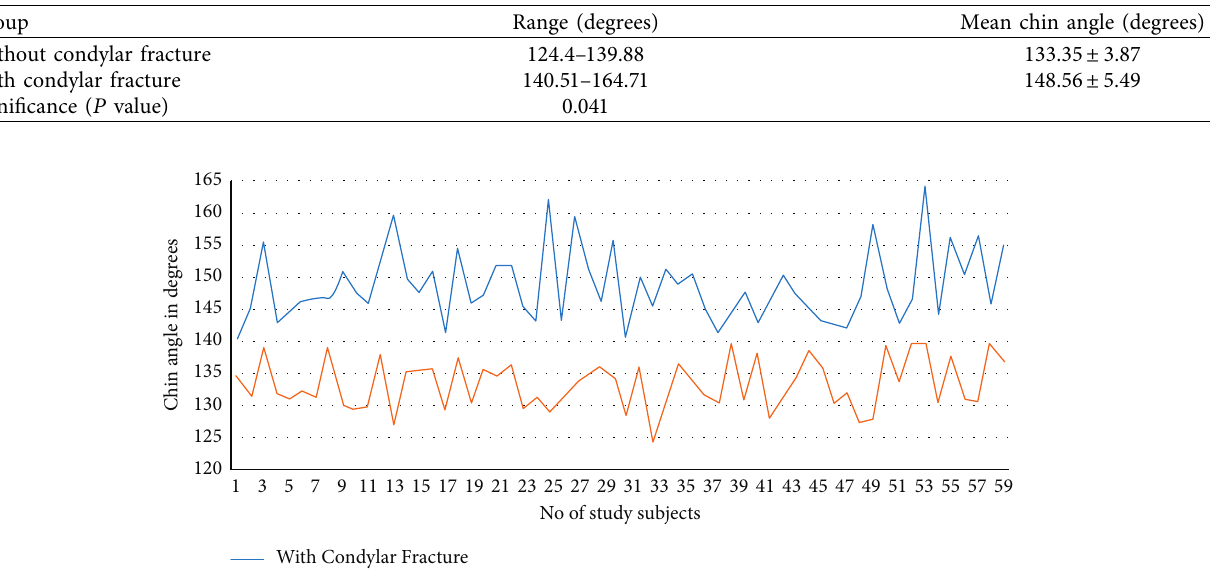
Figure 4: Chin angle in a 2D CT scan of a condylar fracture patient. Table 1: Summary of outcome variables.